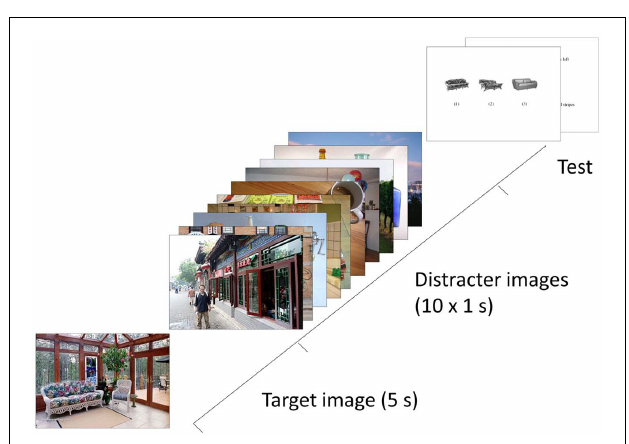
FIGURE 2 | Illustration of the procedure used in the experiment. The target image was presented for 5s, followed by 10 distracter images (or a blank screen) for a period of 10s.Then participants answered a series of multiple choice (three alternative) questions about the identity, location, and color objects in the